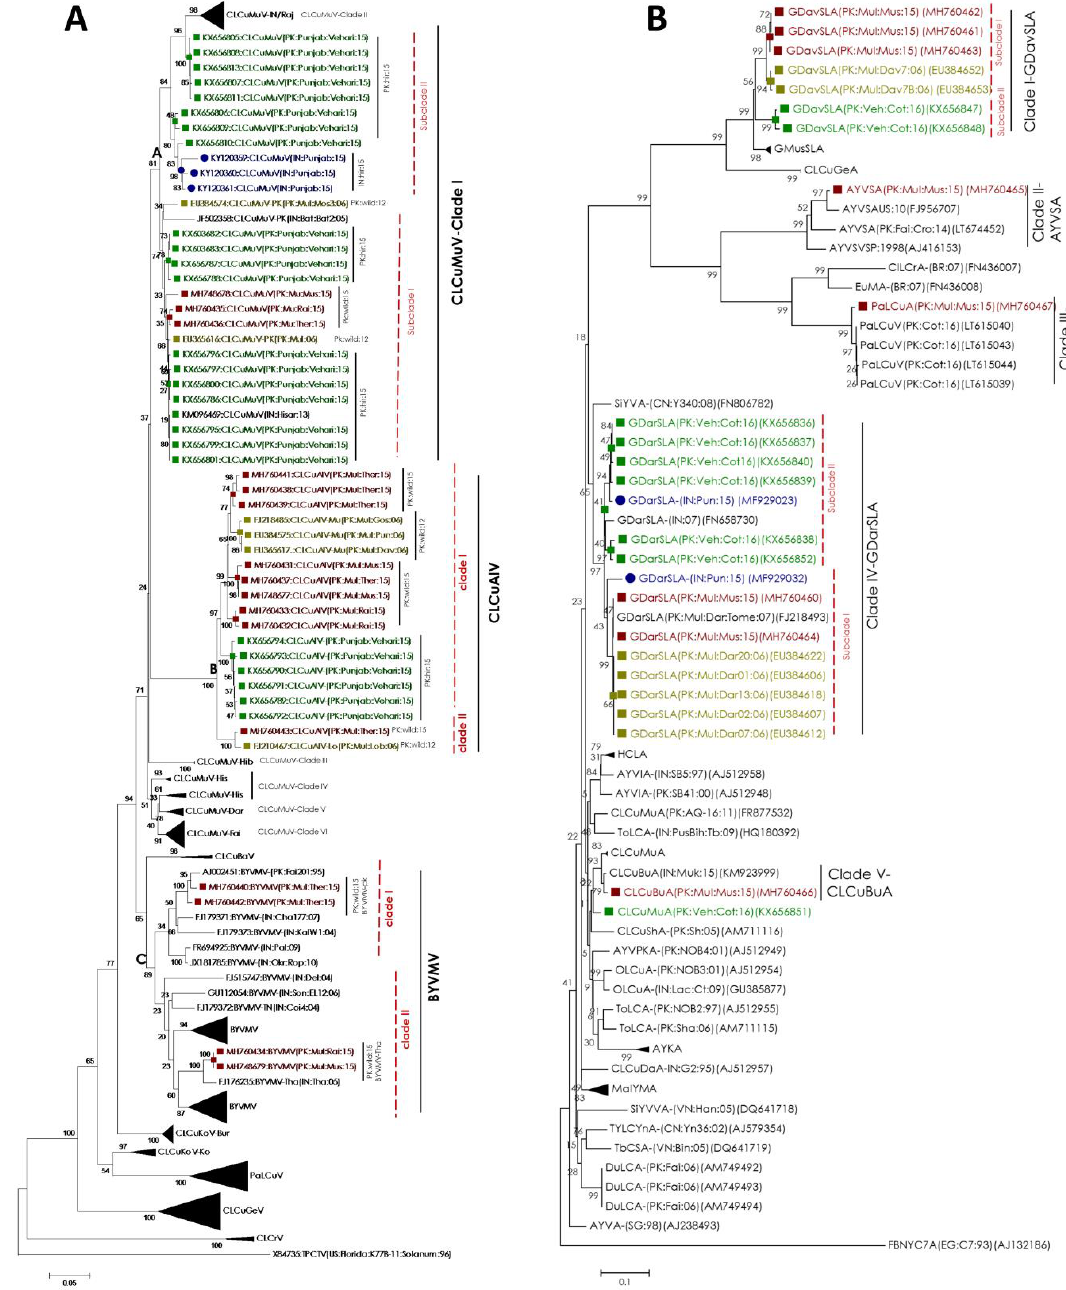
Figure 2. Phylogeny of monopartite and bipartite begomovirus DNA components A and alphasatellites. Neighbor-joining (NJ) phylogenetic dendrogram of monopartite begomoviruses and DNA-A component of bipartite begomoviruses ( A ) and alphasatellites ( B ), generated in this study from non-cultivated cotton species (group named as “PK:wild:15”) with related sequences from database. All DNA-A and alphasatellite sequences found in the current study (Multan, Pakistan, 2015) are represented by solid maroon squares and colored maroon. Sequences reported from non-cultivated cotton species from Multan-Pakistan (2012) [31] are represented by solid olive square and are colored olive (group named as Pk:wild:12). Sequences isolated from cultivated cotton from Vehari-Pakistan (2015) [26] and Punjab-India (2015) [27] are shown by solid green squares and solid blue rounds, respectively. CLCuMuV clades in panel A are illustrated according to recent paper [33]. Begomovirus and alphasatellite species names have been abbreviated according to the revised nomenclature [32].